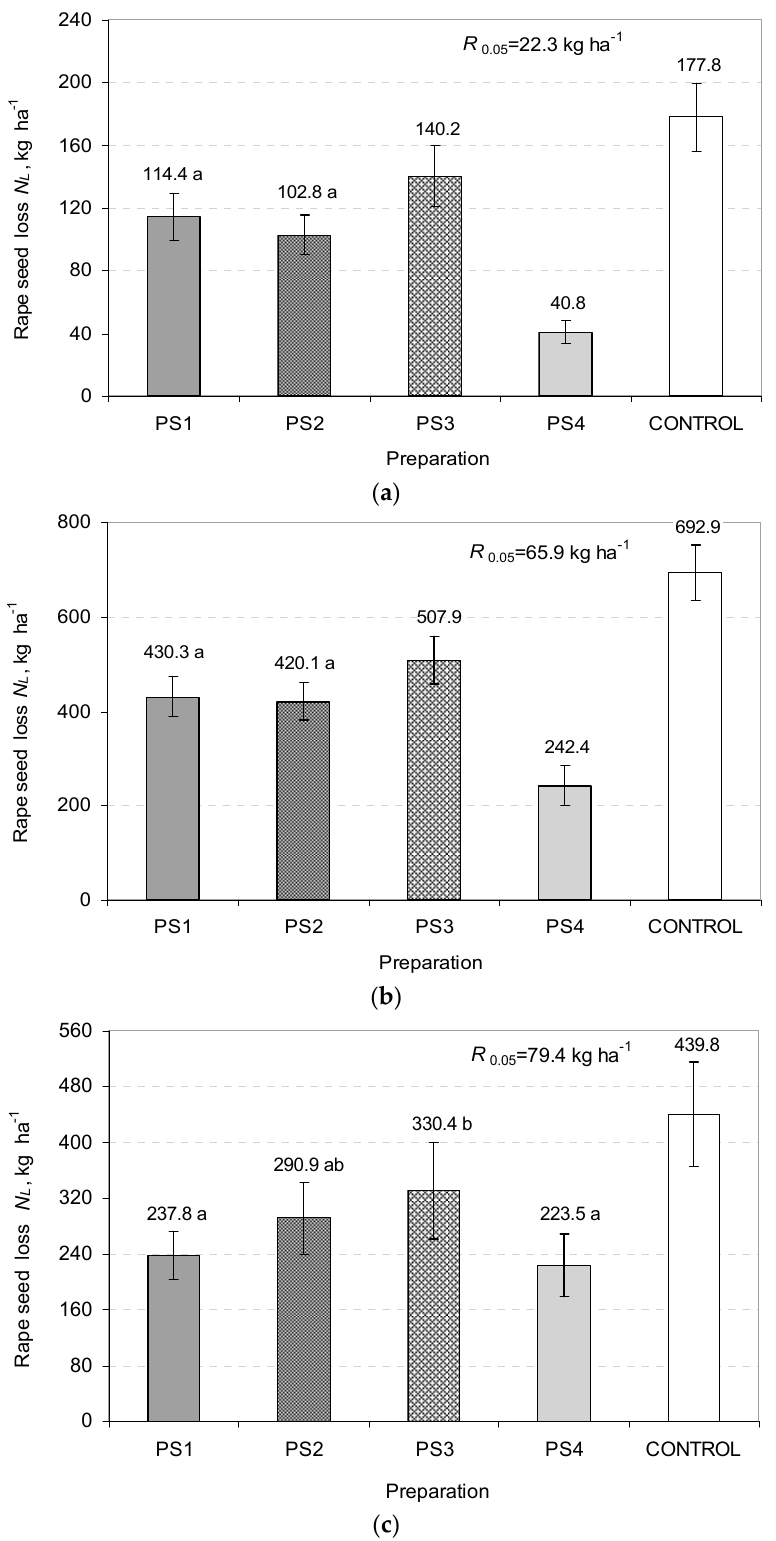
Figure 5. Mean seed losses (±95% confidence limits) due to pod shattering at harvest caused by combine harvester reel tine impact N L (kg ha − 1 ) in 2014 ( a ), 2015 ( b ), and 2016 ( c ). Any two samples with a common letter are not significantly different at the p < 0.05 level.